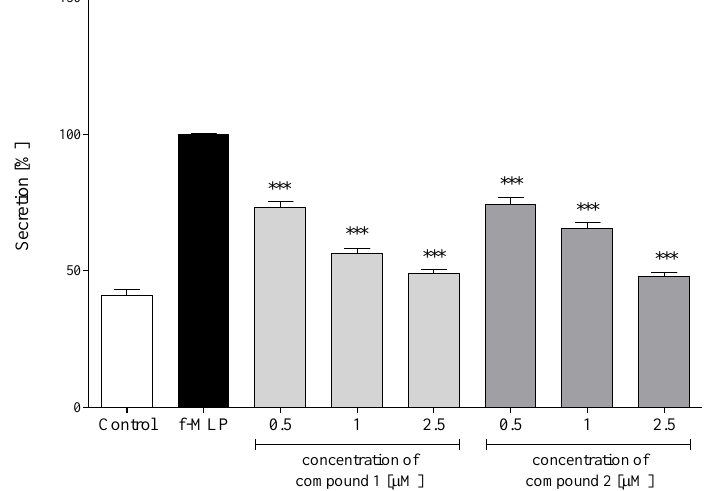
1–2.5 µ M (Figure 5).